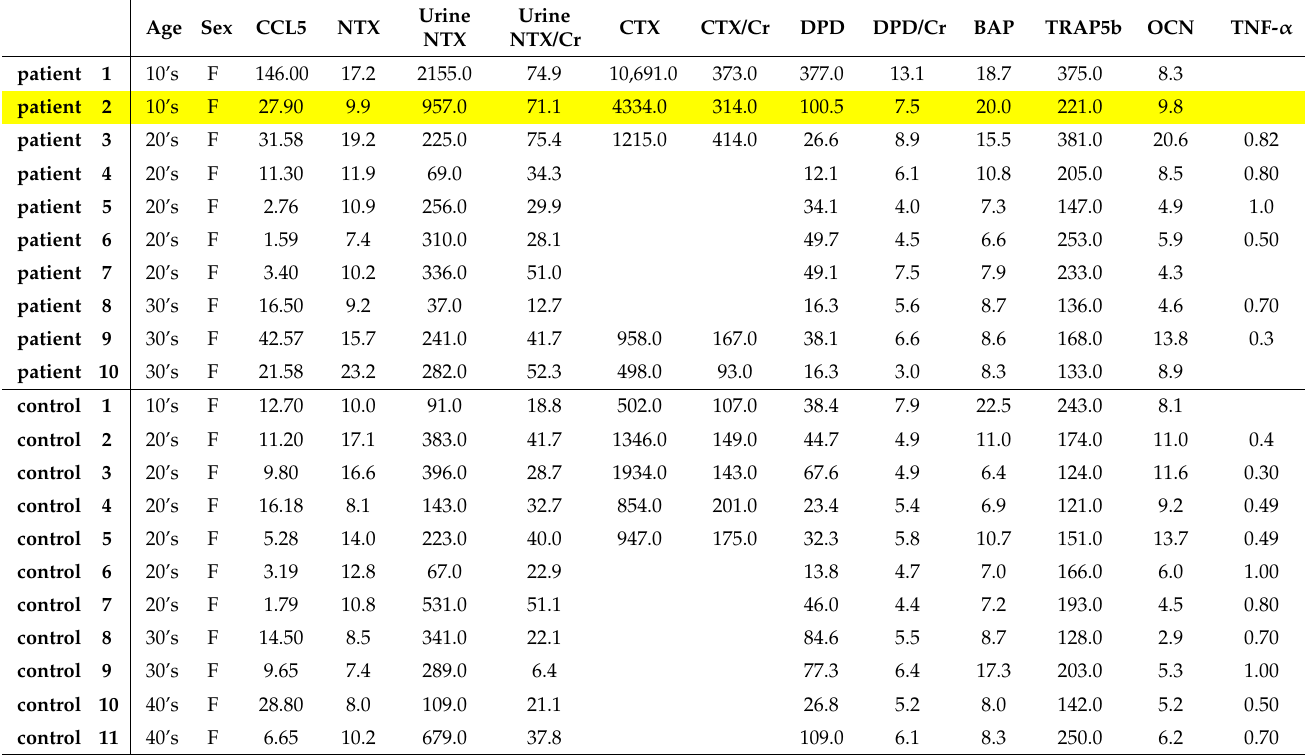
Table 2. List of laboratory results for DJD-TMJ and control subjects at ≤ 42 years old (Younger subjects). Highlighted in yellow shows patients with systemic diseases.